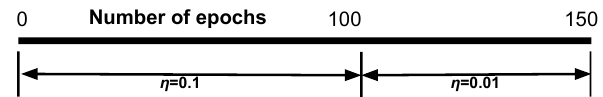
Fig. 1 Experiment setting showing the number of epochs and learning rates corresponding to epochs for training all the models.